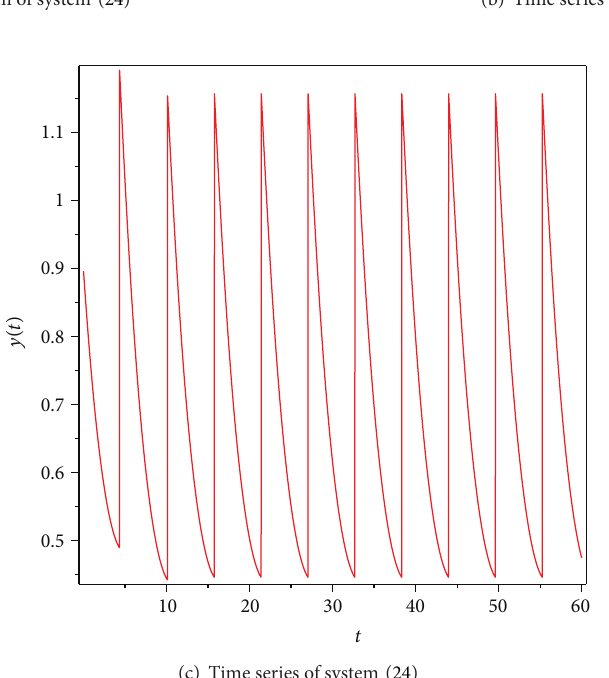
Figure 24: Illustration of basic behavior of system